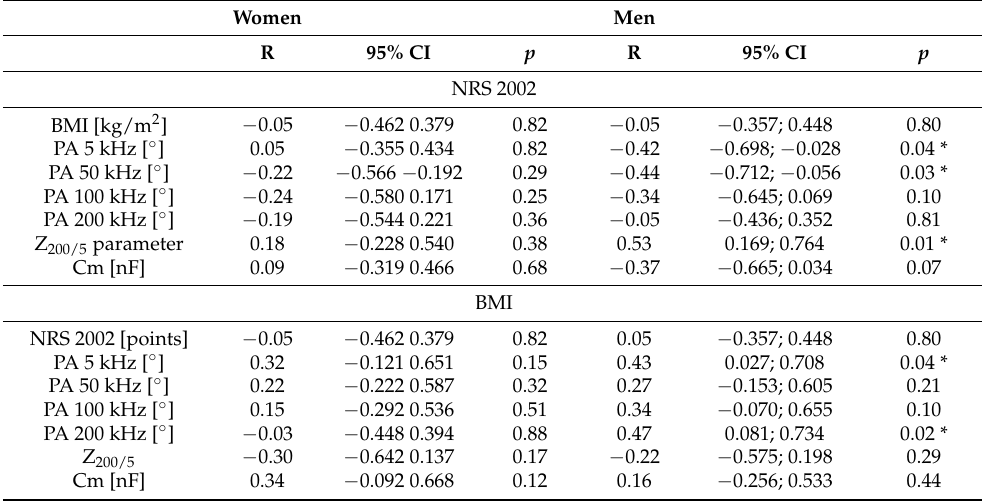
Table 4. Correlation between nutritional status parameters among women and men subgroups.